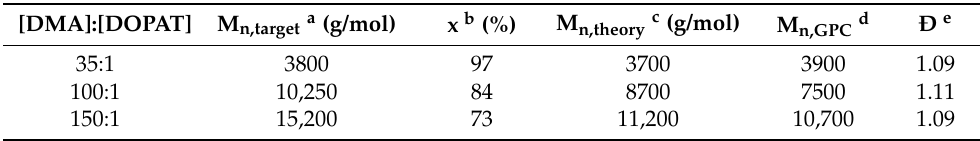
Table 1. Data for the reversible addition-fragmentation chain transfer (RAFT) mediated polymerization of N , N -dimethylacrylamide (DMA) at 65 °C in dioxane.